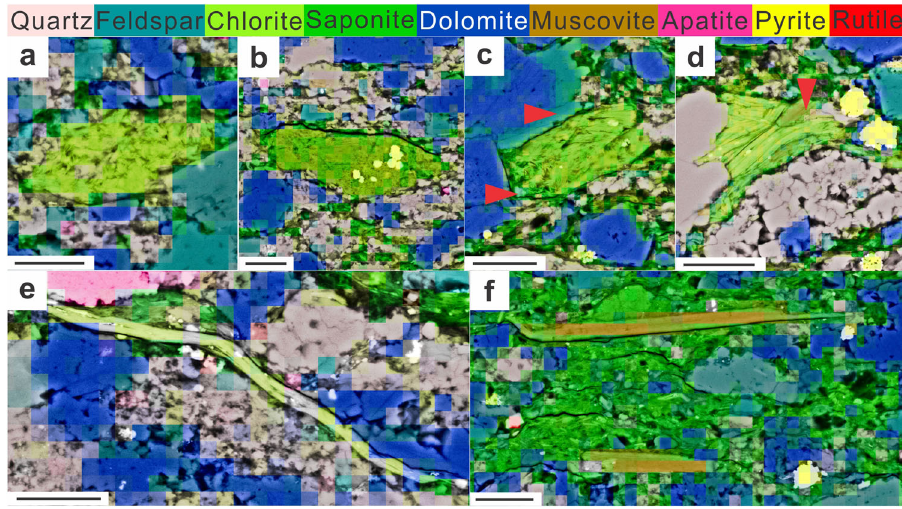
Fig. 5 SEM-EDS mineral mapping images of representative examples of chlorite and muscovite from the Doushantuo Formation. Scale bars represent 10 μ m ( a ) SX12, randomly oriented, intergrown chlorite-saponite fl akes fi lling a pore interpreted to be a fully chloritized saponite intergranular pore- fi ll similar to Fig. 4d, f. b Qlk10, partially oriented, chlorite-saponite pore- fi ll with similar texture as unaltered saponite and pyrite inclusions ( c ) Qlk7, chlorite with fl aky texture replacing a feldspar grain. Note the feldspar residue at the top and the bottom left corner (red arrows) interpreted to be a fully chloritized saponite aggregate similar to Fig. 4g. d Qlk7, partially chloritized muscovite fl akes (red arrow denotes muscovite residue). e SX4, long chlorite fl ake